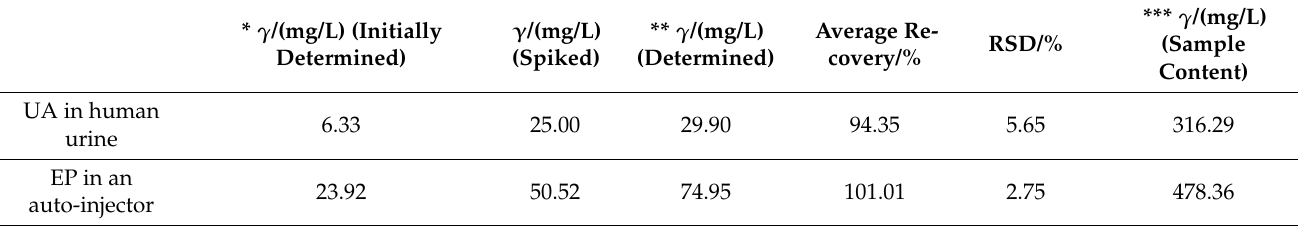
Table 5. Real sample analysis results for UA and EP obtained using the best weighted model. All values are given as the average of three